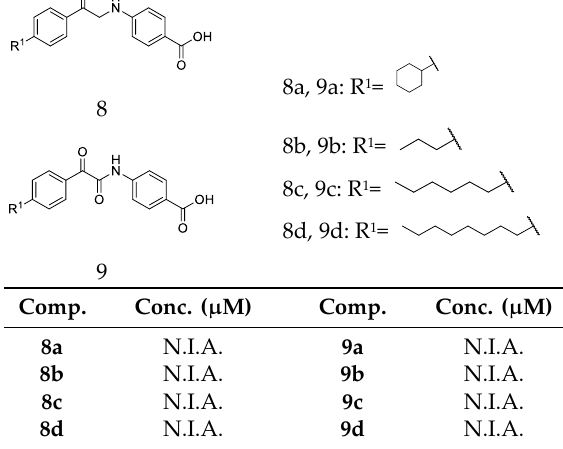
Figure 4. The bands of compounds 3 , 6p , 6q , and 6m interacted with MCR-1 protein for inhibiting the reaction of phosphoethanolamine (PEA) transfer by thin layer chromatography (TLC); Control 1: The